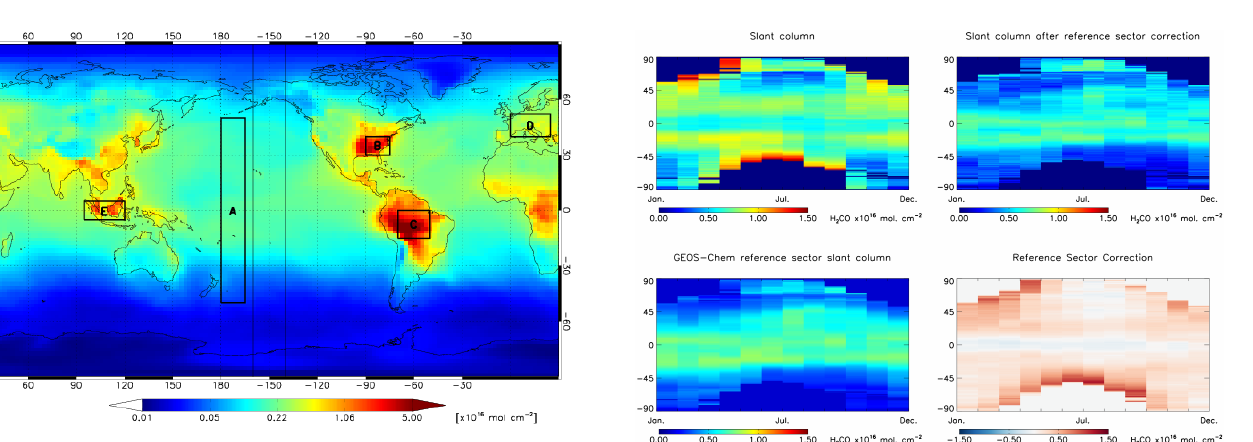
Figure 7. Analysis of the reference sector correction using monthly averages for the year 2007. Top left panel shows OMI-retrieved SCD for the reference sector (140 to 160 ◦ W), top right panel shows the OMI SCD after the reference sector correction is applied, bot- tom left panel the reference sector concentration from the GEOS- Chem climatology, and the bottom right panel the correction applied for each month and latitude